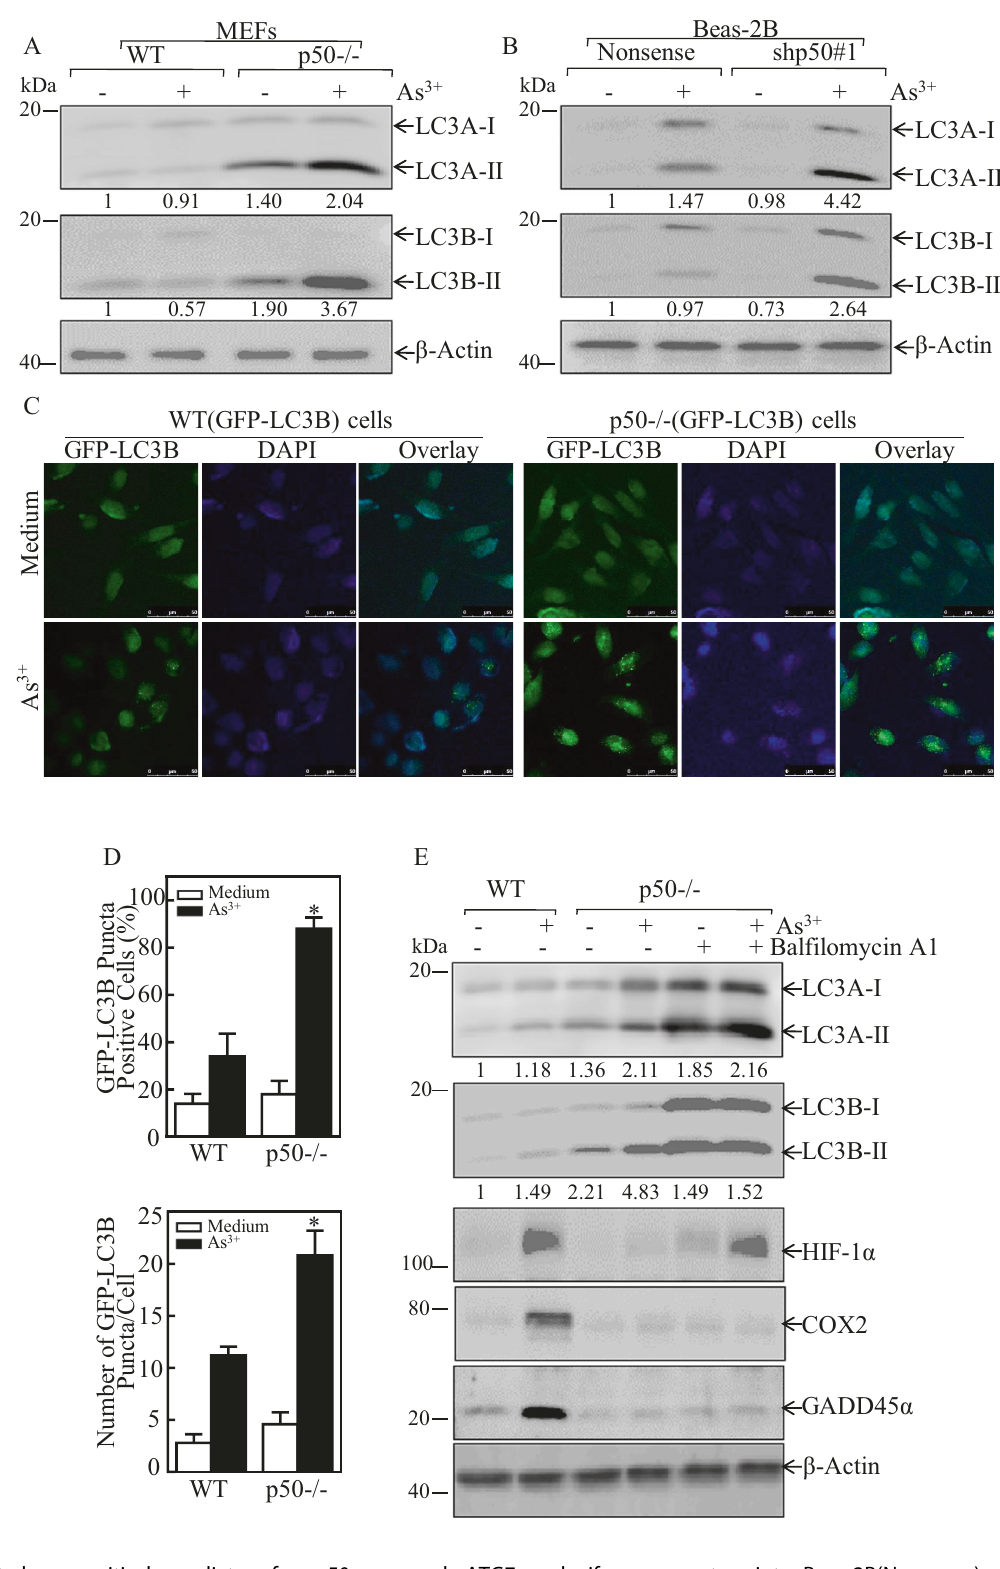
Sp1 might be a critical mediator for p50-repressed ATG7 expression. To de fi ne the effect of Sp1 on ATG7 transcriptional activity, the Sp1 binding site point mutation in the ATG7 promoter-driven luciferase reporter was constructed. We further transfected both the wild-type or mutant ATG7 promoter-driven